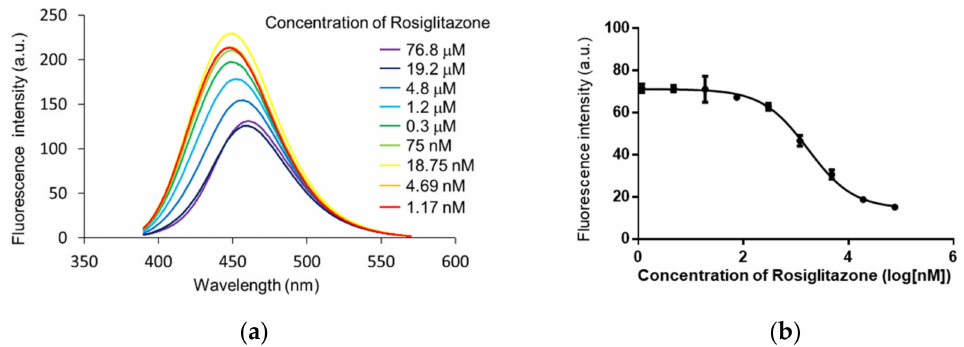
Figure 8. Fluorescence binding assay using the fluorescence intensity of 2 at Ex = 367 nm in the presence of 0.6 µ M hPPAR γ -LBD in Tris–HCl buffer. ( a ) Fluorescence spectrum of 2 (0.72 µ M) and hPPAR γ -LBD (0.6 µ M) upon addition to rosiglitazone (1.17 nM–76.8 µ M) in Tris–HCl buffer at Ex = 367 nm. ( b ) Fluorescence intensity of 2 at 410 nm in the presence of 0.6 µ M hPPAR γ -LBD at various concentrations of rosiglitazone. Data are mean ± SD (n =